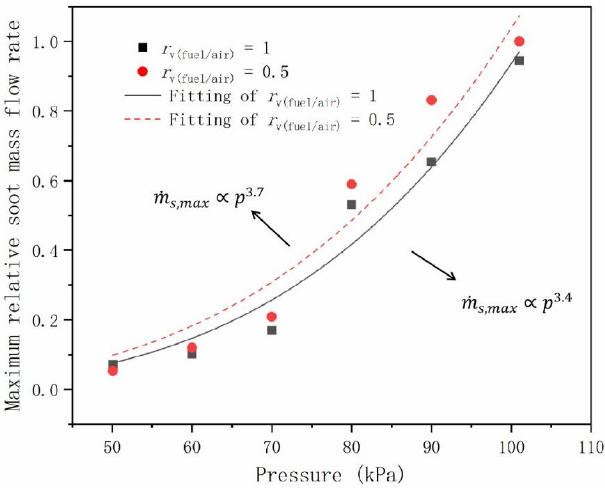
Figure 9. Power law fit of the maximum relative soot mass flow rate and pressure.